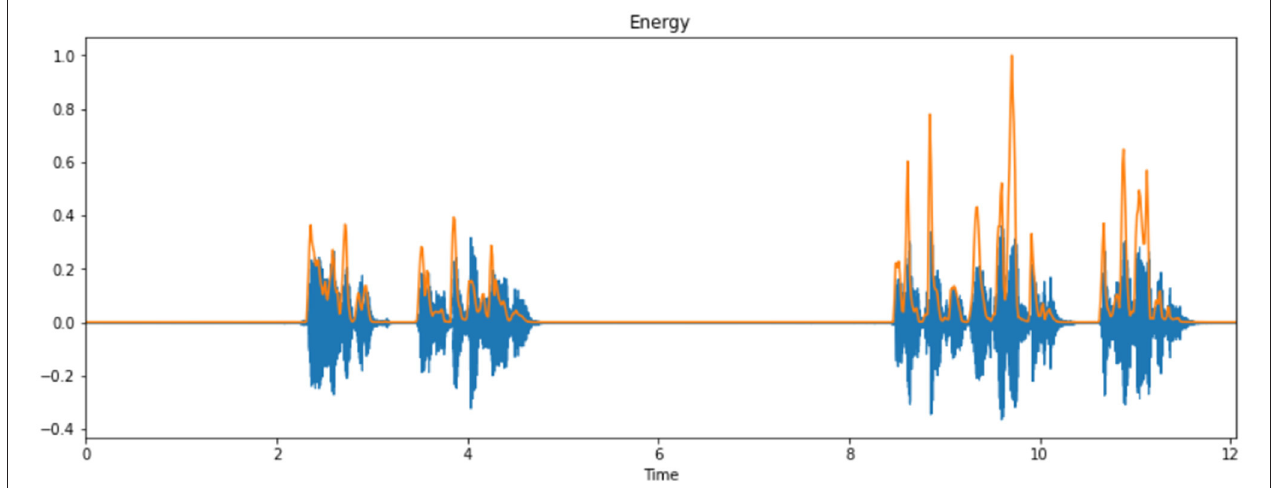
FIGURE 1 | Infant cry acquisition setup and analysis.